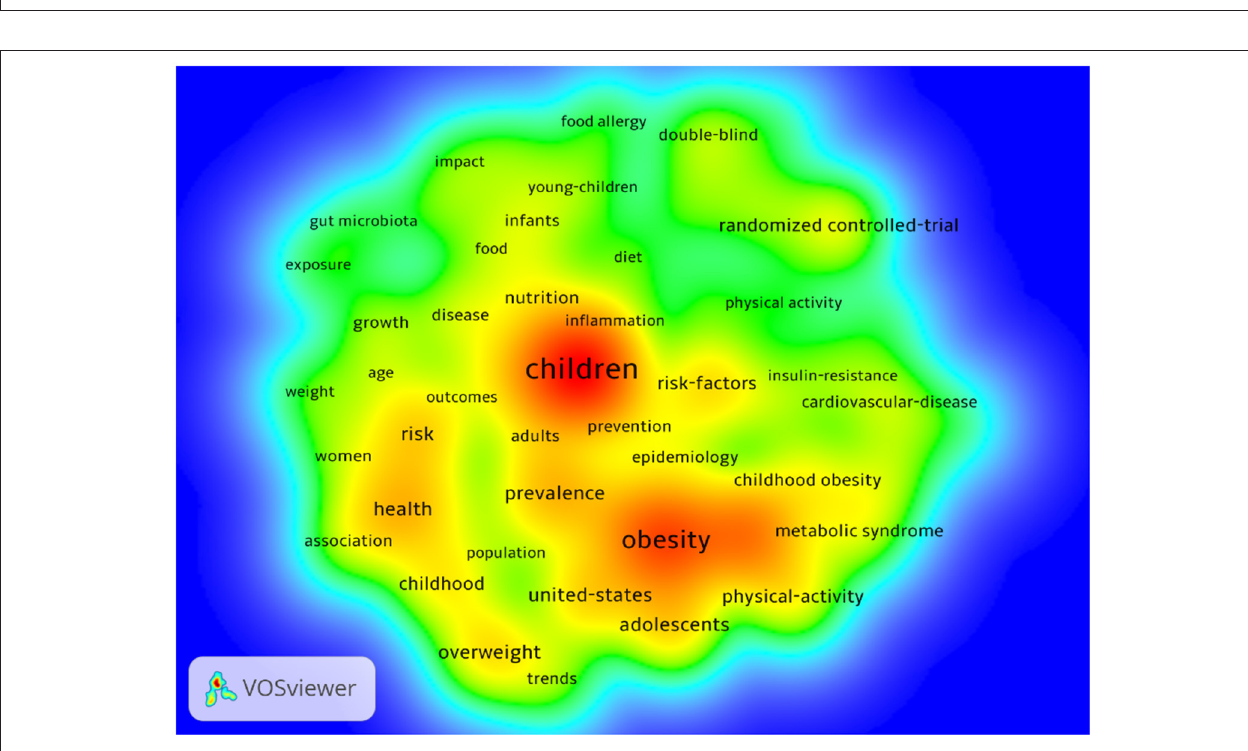
FIGURE 4 | Top 20 references with the strongest citation burst.